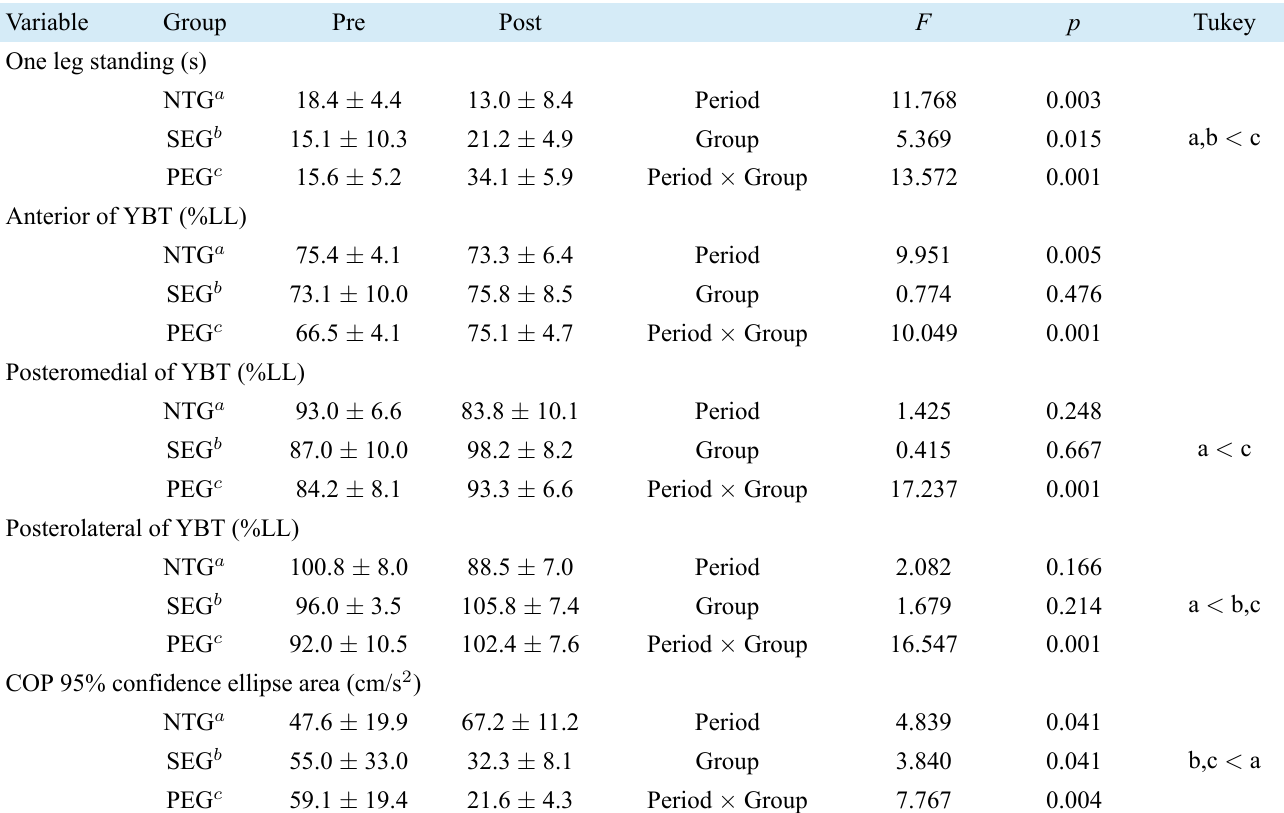
TABLE 5. Changes in dynamic balance and GRF of the ipsilateral